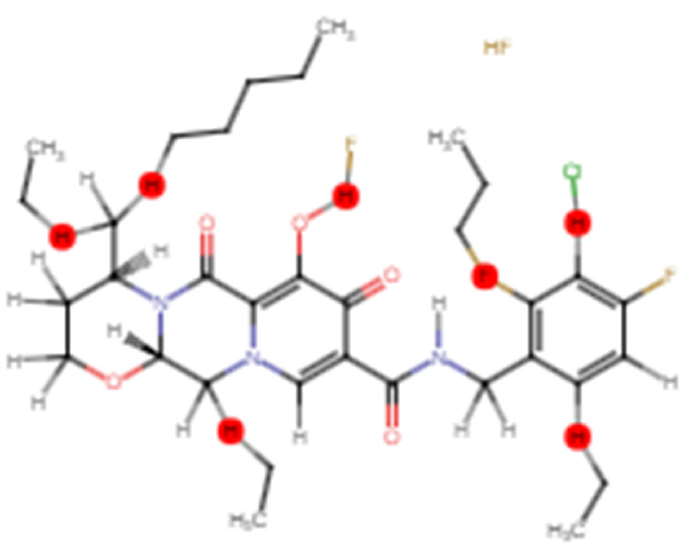
Figure 4. Chain engineered structure of dolutegravir; red points are representing the sites of addition of chains or atoms; brown color shows the added atom of fluorine and chlorine is presented by green color.